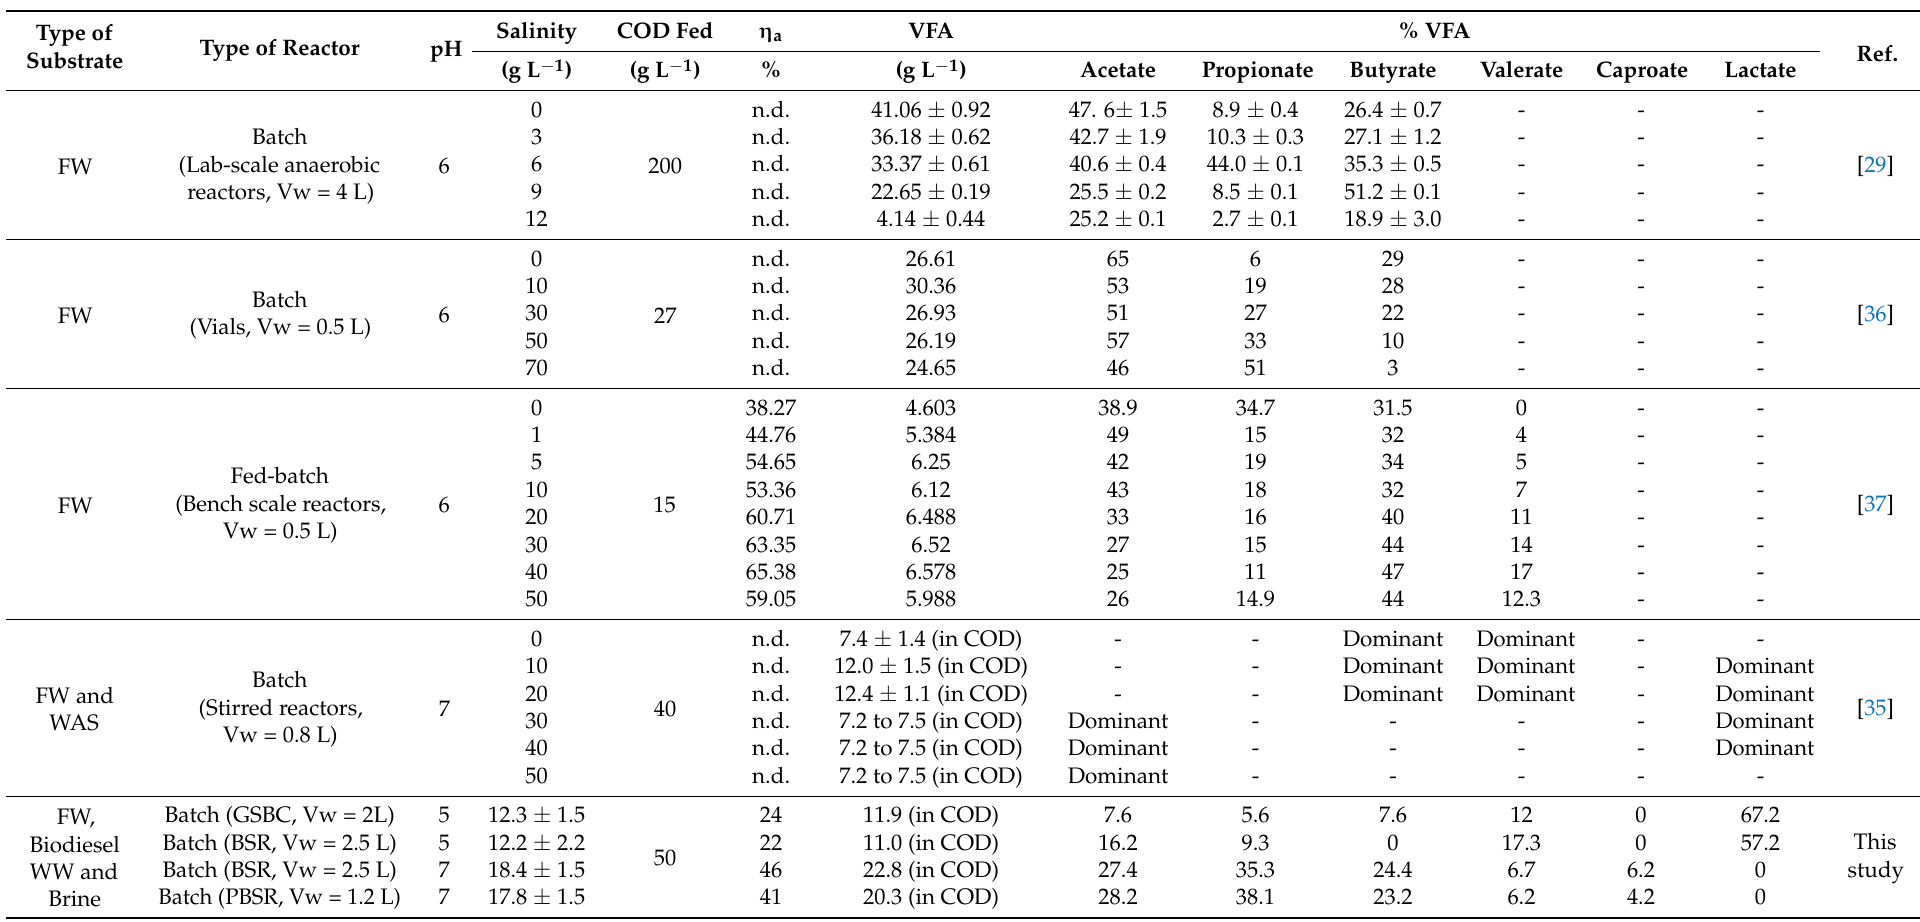
Table 3. Performance of acidogenic processes using FW and food processing WW with high salinity content. (n.d.—not